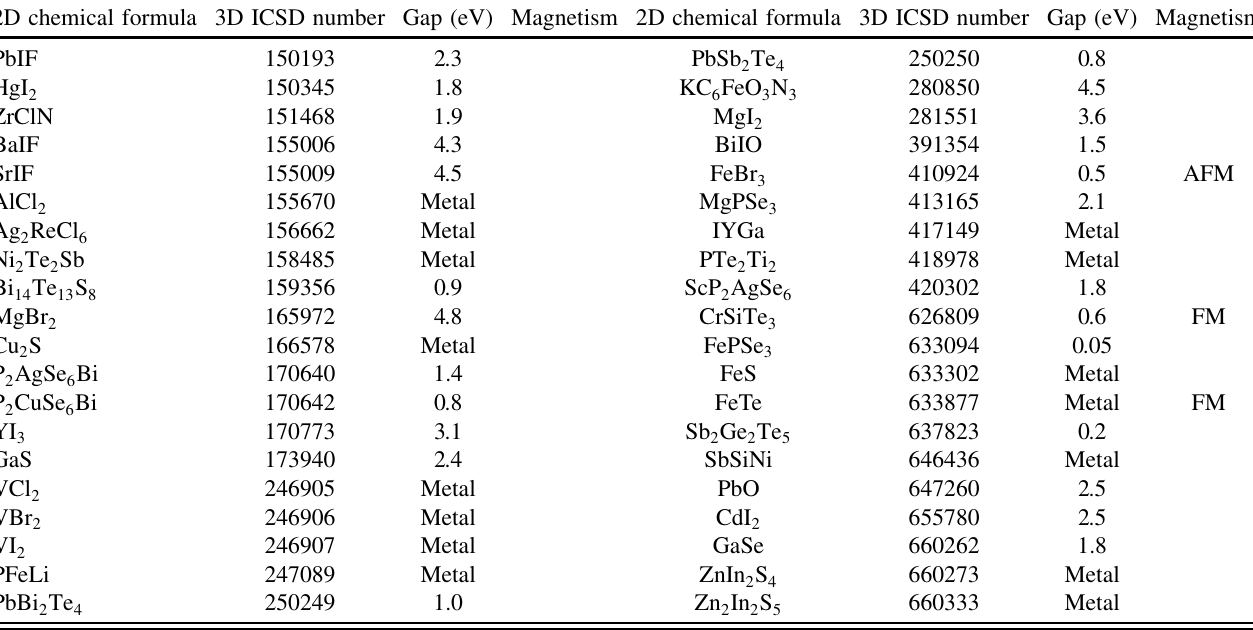
FIG. 1. Computed band structure of ZrSe (left) and HfSe 2 2 (right) along the high-symmetry directions (cid:3) - M - K - (cid:3) . The Fermi level is at zero energy. TABLE III. List of compounds found by our algorithm that do not belong to the family of dichalcogenides. The chemical formula, the ICSD number of the corresponding bulk material, the value of the minimum band gap, and an eventual magnetic ordering are given in the different columns from left to right. (The cells of the table are left blank if the material is not magnetically